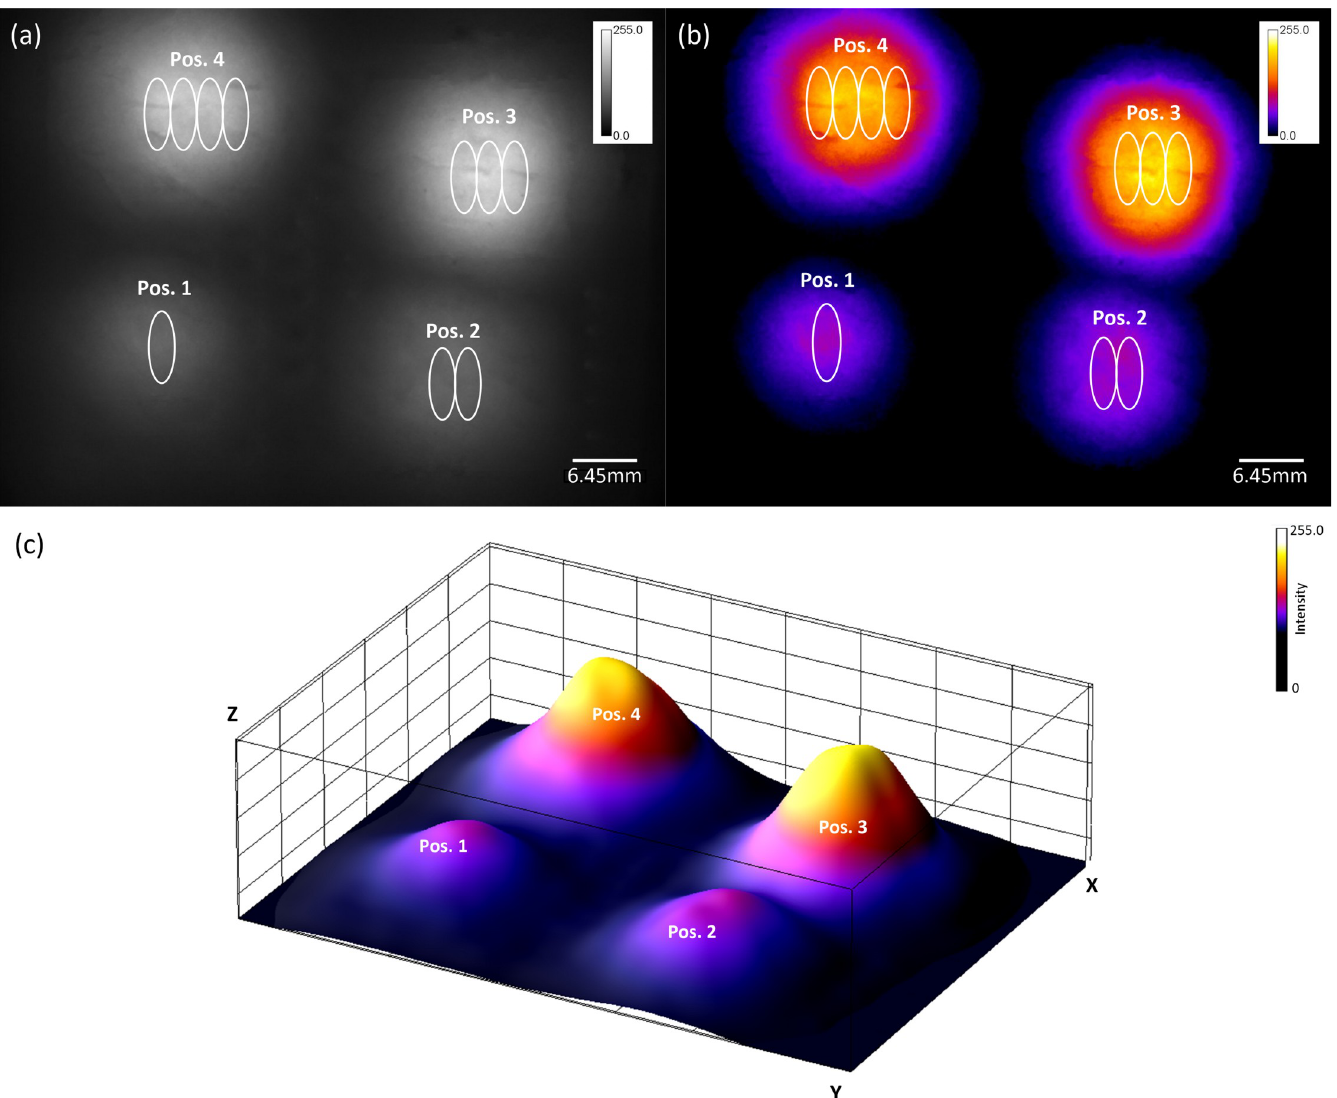
Fig 4. Results of the tissue area scan. (Fig 4A) Tissue scan of an area of 10 cm × 6.6 cm with four differently sized tumor phantoms (phantom sizes: Position 1, 7 × 2 mm; Position 2, 7 × 4 mm; Position 3, 7 × 6 mm; Position 4, 7 × 8 mm) with an exposure time of 100 ms at a depth of 22 mm. (Fig 4B) False-colored image of the scanned tissue sample recorded using the developed laser scanner. (Fig 4C) Three-dimensional surface plot of the detected tumor phantoms.